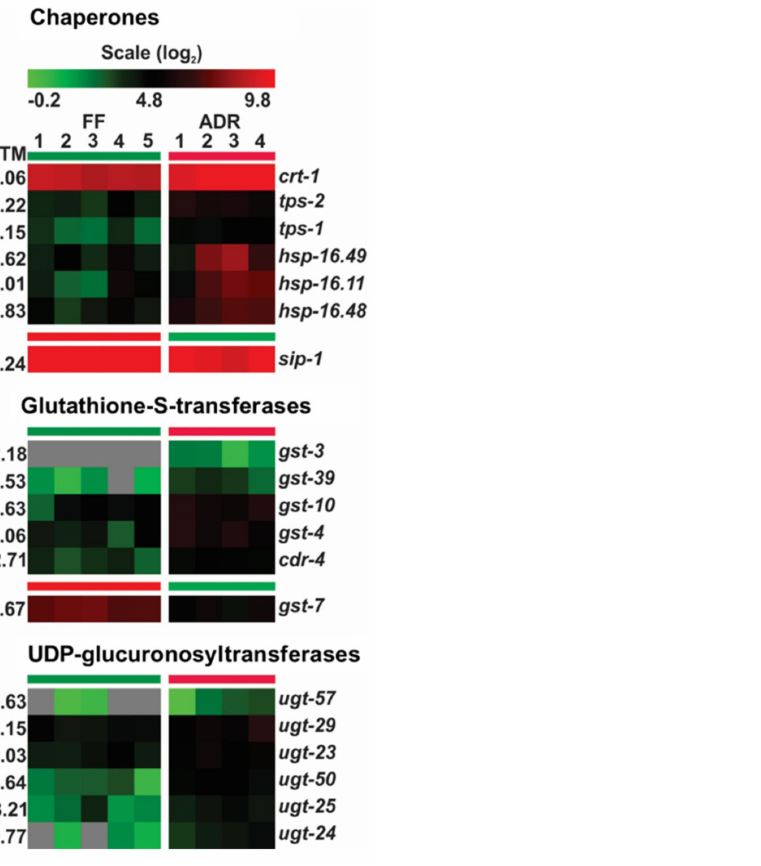
Figure 5. Expression of genes involved in cellular protein homeostasis and xenobiotic detoxification. FF = fully fed, ADR = axenic dietary